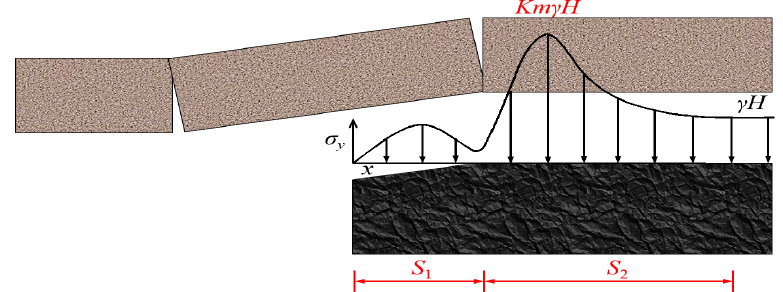
Figure 14. Structural mechanics model of gob-side entry driving [52].